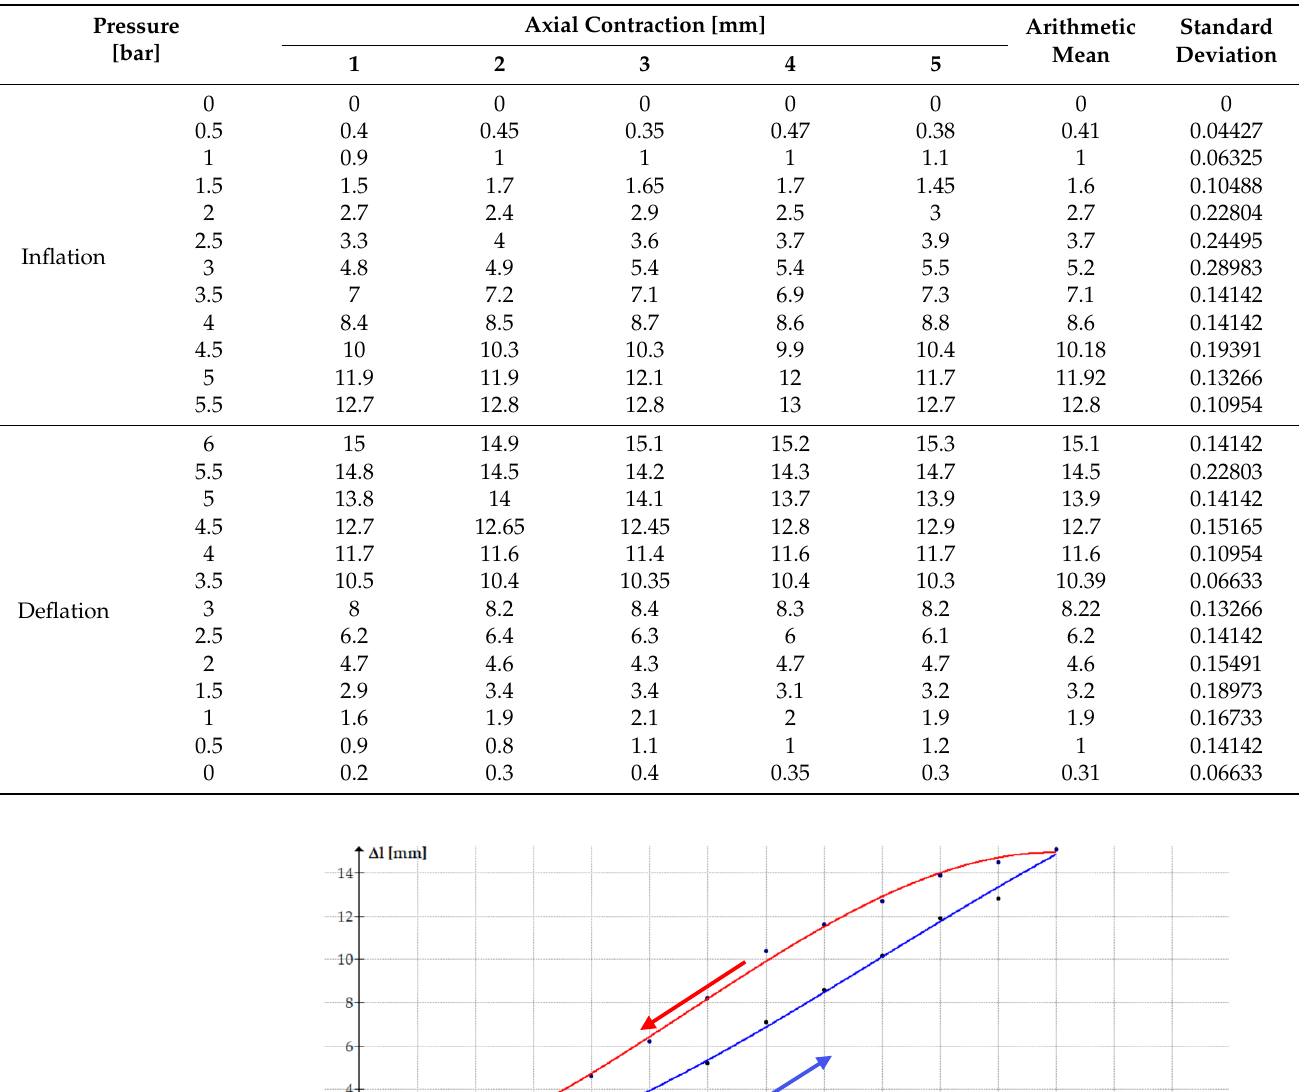
Table 3. Muscle axial contraction for zero external load.